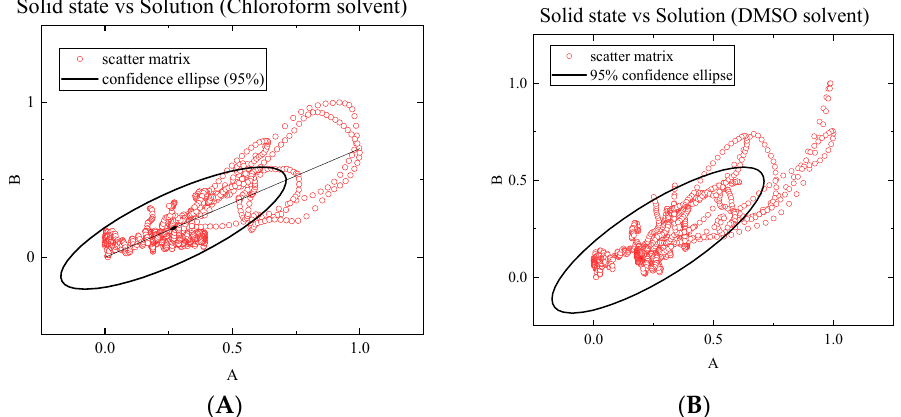
Figure 4. Confidence ellipses calculated from Pearson-type correlations for the solid and the solution with CHCl 3 ( A ) or DMSO ( B ) used as solvent. See text for